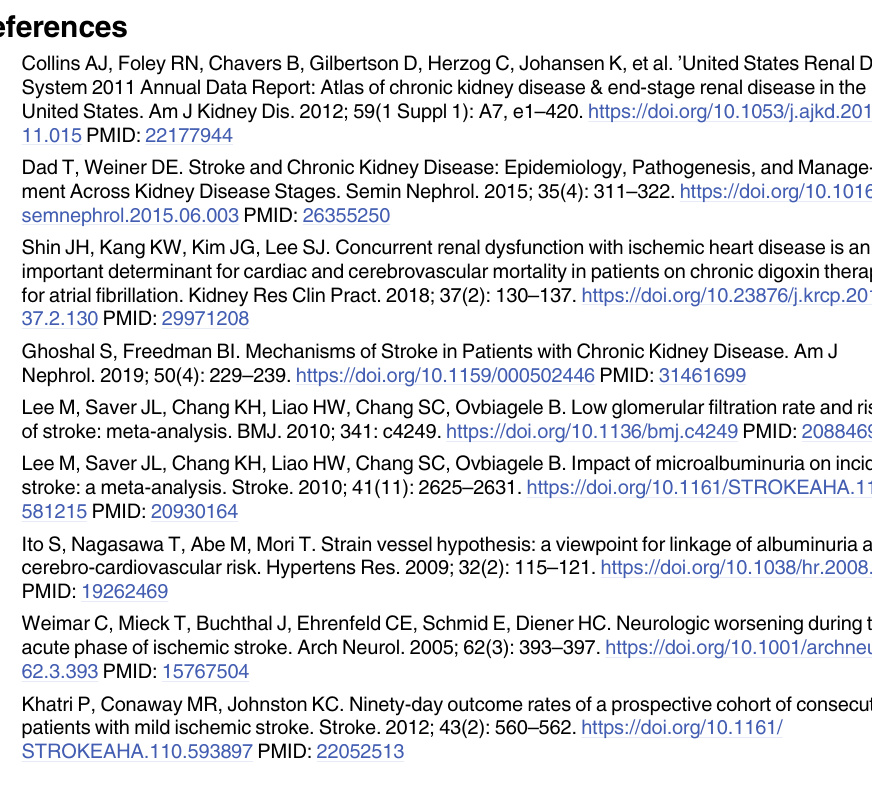
S3 Table. Interaction between renal function and BPV parameters for the occurrence of END. (DOCX) S4 Table. Database containing patient information. S1 Fig. Study flow chart. NIHSS, National Institutes of Health Stroke Scale.